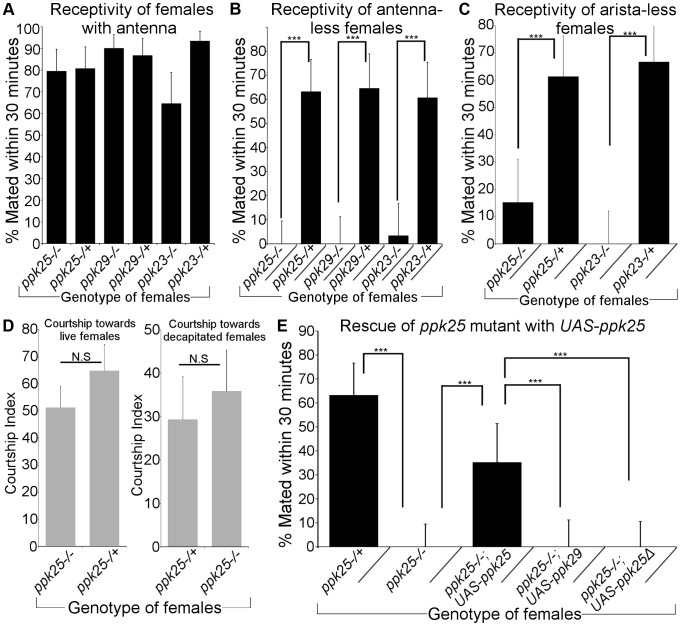
Antenna-less females mutant for ppk25, ppk23 or ppk29 are unreceptive to males.A. The percentage of females that mated within 30(“Receptivity”) was calculated for females with homozygous null mutations in ppk25, ppk23 or ppk29[11], [13], [16], and for control females with one normal copy of ppk25, ppk23 and ppk29. N = 30–34. For receptivity in Fig. 5 and 6, error bars indicate the SEM. B. Antenna-less females mutant for ppk25, ppk23 or ppk29 show reduced receptivity to males. Receptivity was measured for mutants and control females as in A but after removal of antennae. N = 30–38; ***p<0.001. (Fisher's exact test). C. Arista-less females mutant for ppk23 or ppk25 show reduced receptivity to males. Receptivity was measured for mutants and control females as in A but after removal of arista. N = 21–32; ***p<0.001. (Fisher's exact test). D. wt males find ppk25 mutant and control females equally attractive. CI measured for Canton-S males toward females that were either alive (left) or decapitated (right). CI of males toward live females was quantified by measuring male courtship behavior during the first 10 minutes of the receptivity assay shown in Fig. 5B. Females were either homozygous null mutants for ppk25 or contained one normal copy of ppk25. N = 20. E. Introduction of a ppk25 transgene increases receptivity of ppk25 mutants but not of ppk29 mutants. Receptivity was measured for antenna-less females carrying an UAS-ppk25 transgene in either a ppk25 mutant or ppk29 mutant background and compared to ppk25 mutant and controls shown earlier (panel A). N = 30–38; ***p<0.001 (Fisher's exact test).